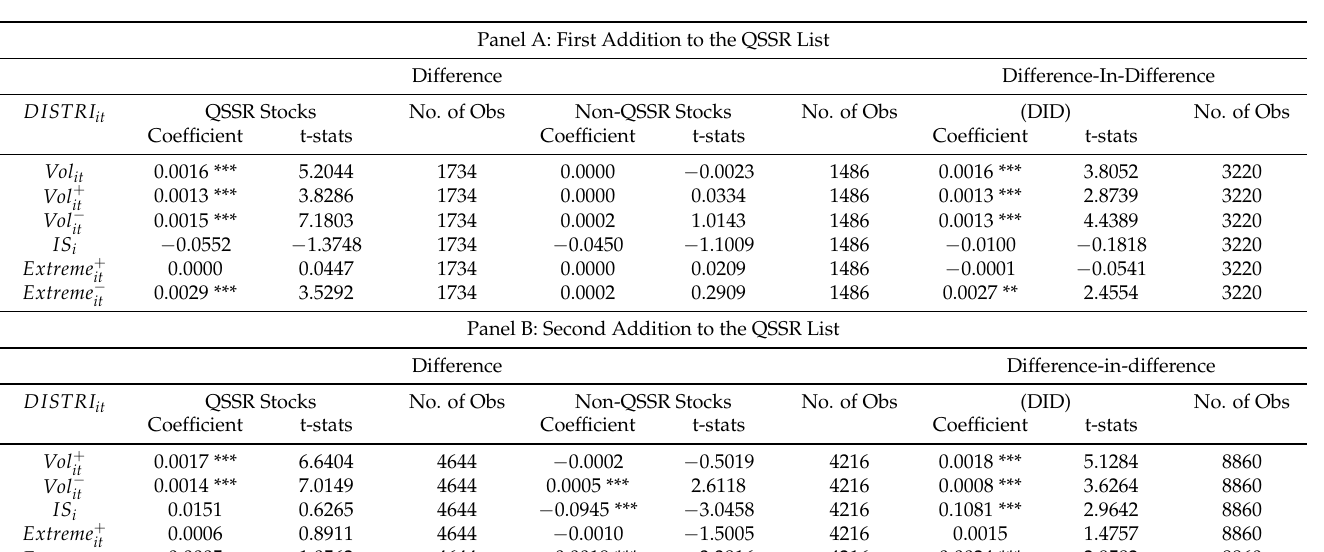
Table 8. Changes in the distribution of returns after additions to the QSSR